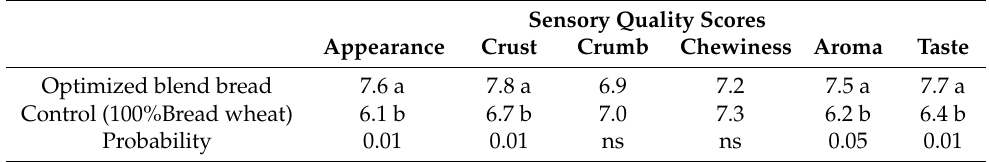
Table 4. Sensory quality scores of optimized blend bread compared to wheat bread (control). Sensory Quality Scores Appearance Crust Crumb Chewiness